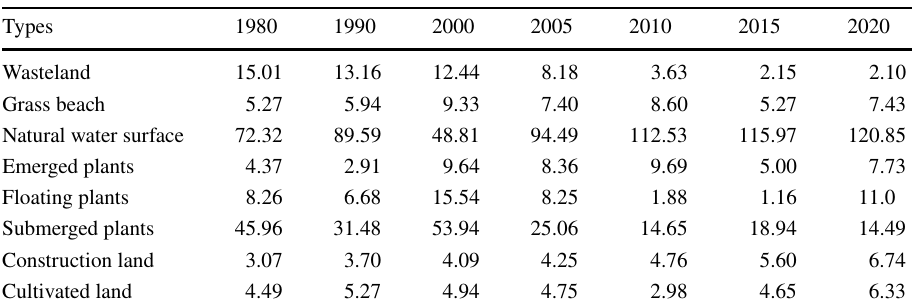
Table 7 The wetland landscape